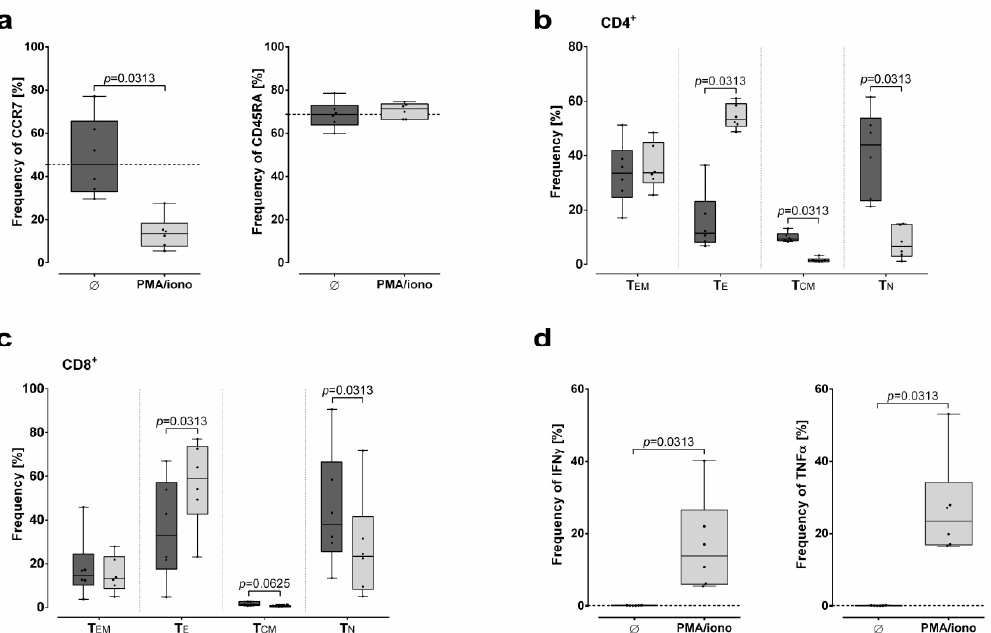
Figure 2. Influence of PMA/Ionomycin stimulation on T cell differentiation and cytokine response. Effect of PMA/Ionomycin stimulation for 4 h on ( a ) the surface expression of CCR7 and CD45RA, differentiation of ( b ) CD4 + and ( c ) CD8 + naïve (T N ), central memory (T CM ), effector (T E ), and effector memory (T EM ) T cell subsets, and ( d ) the cytokine response. Frequencies of cell populations (%) are presented as median with minimum and maximum. Black dotted line indicates the median frequency of a certain population obtained without PMA/Ionomycin stimulation. Statistical analysis was performed by Wilcoxon test.